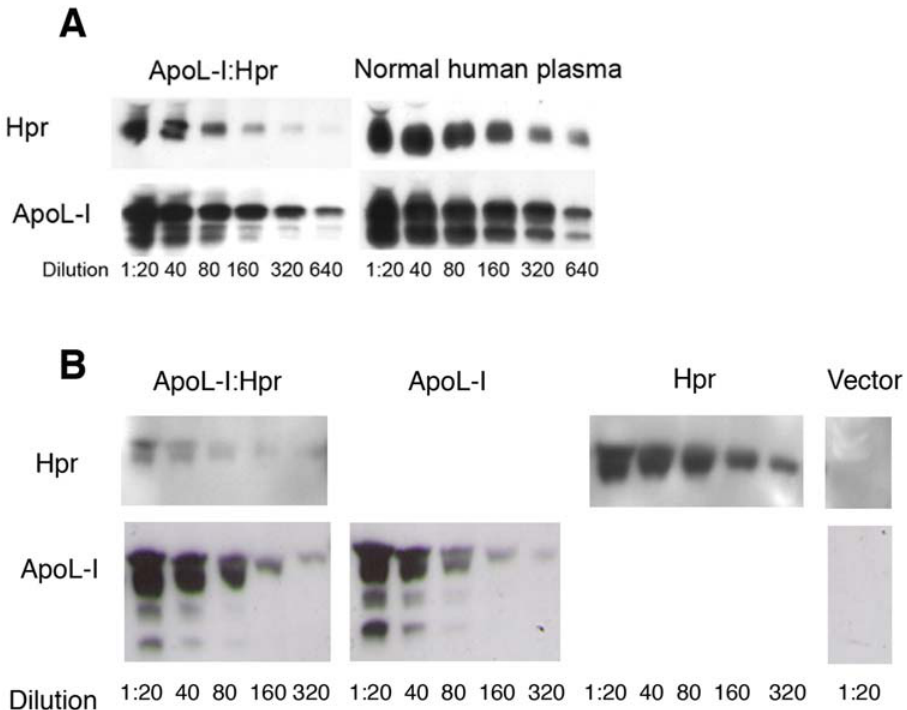
Figure 7. Protein levels of Hpr and apoL-I in HDG-TLF murine plasma compared to human plasma. Western blot of serial dilutions of plasma from mice expressing Hpr and apoL-I from a single plasmid (apoL-I:Hpr) 3 days post-injection, compared to normal human plasma (A). Western blot of serial dilutions of plasma from mice injected with plasmids coding for Hpr, apoL-I, both (apoL-I:Hpr), or no protein (vector) 3 days post-injection (B). Hpr and apoL-I were detected with monoclonal